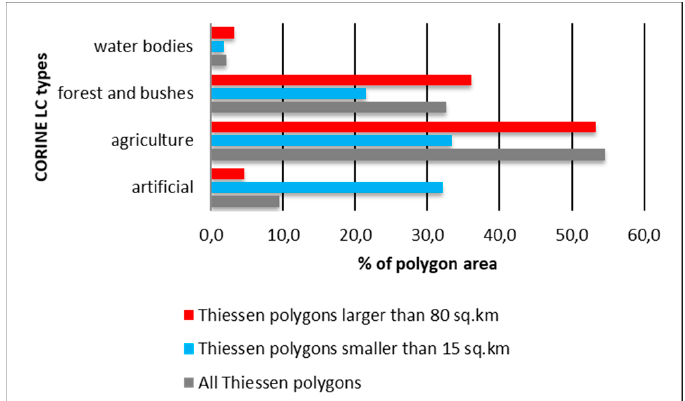
Figure 9. Thiessen polygons –land cover structure.